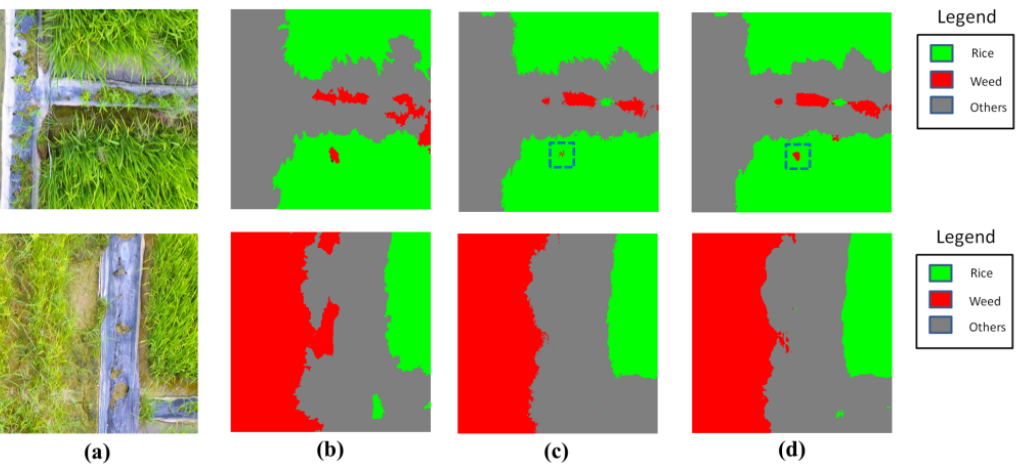
Figure 11. The classification results obtained by ASPP-1 before and after CRFs. ( a ) aerial images; ( b ) corresponding GT labels; ( c ) output by ASPP-1 before CRFs; ( d ) output by ASPP-1 after CRFs. Table 7. Experimental results of CRF.